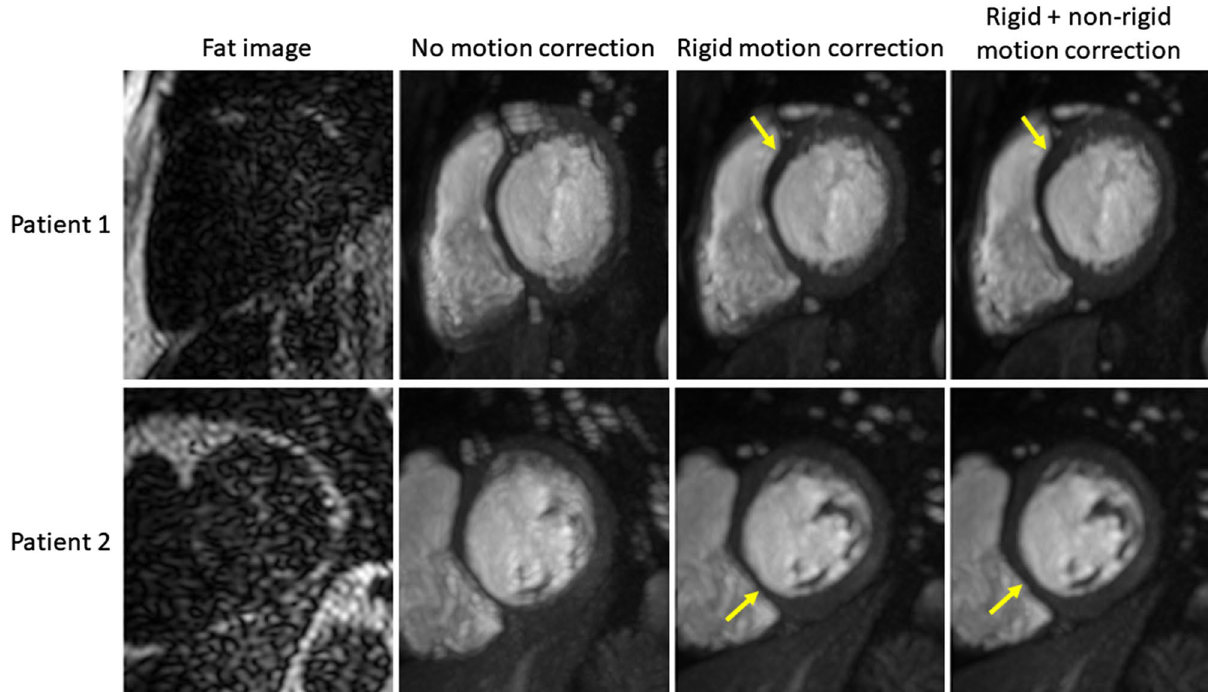
Figure 5. The temporal maximum intensity projection of the image series of two patients. The images shown are the basal slice from two different patients. The first column shows the corresponding fat image that was used for the rigid correction. The increased sharpness and clearly defined features that are evident after motion correction indicate a lack of motion. The arrows indicate regions where the fat images are lacking structural information and hence the second, non-rigid stage of the correction is required to accurate delineate the